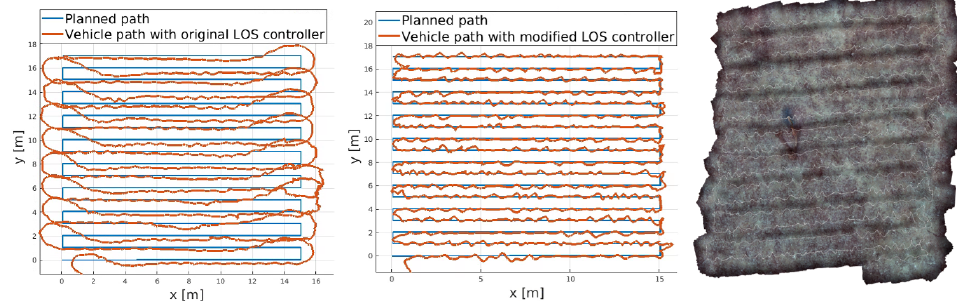
Figure 26. ( Left ) Vehicle’s path, employing the SPARUS II configuration along a survey mission; ( Center ) Vehicle’s path, employing the ALICE configuration along a survey mission; ( Right ) Actual path calculated from camera positions on top of the generated mosaic.